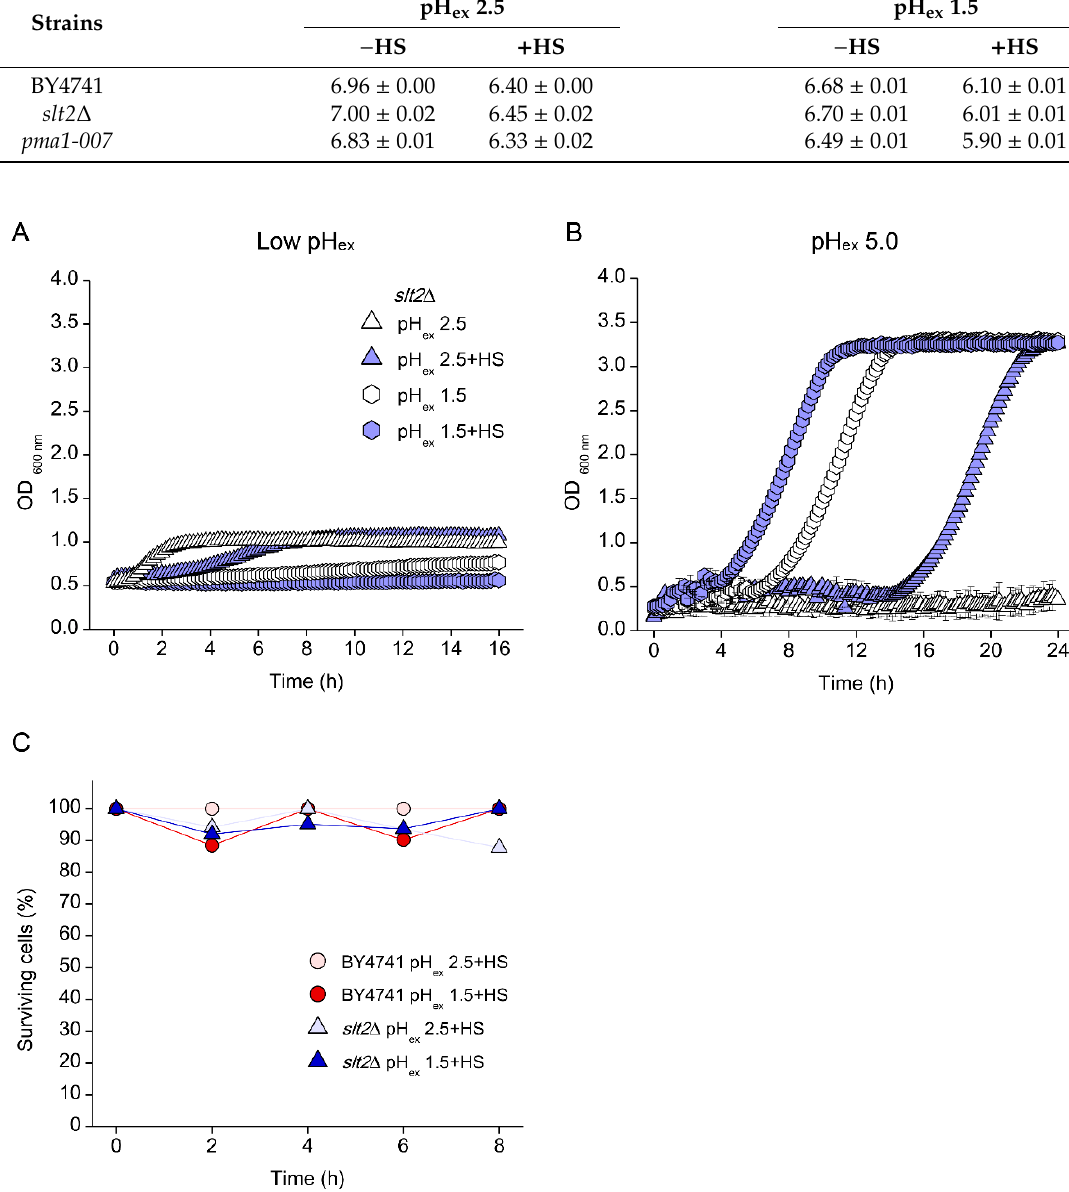
Figure 7. E ff ect of sorbic acid on the growth profile of S. cerevisiae slt2 ∆ mutant cultivated in low external pH (pH ex ) medium. ( A ) Cells of were cultivated in YNB adjusted to pH 2.5 (blue triangles) or pH 1.5 (blue hexagon) with sulphuric acid in the absence (open symbols) or presence (closed symbols) of sorbic acid at 1.2 mM. ( B ) At the end of cultivations, their cells were collected and transferred to YNB pH 5.0. ( C ) Cultures of BY4741 (circles) and slt2 ∆ (triangles) strains in YNB containing sorbic acid and adjusted with sulphuric acid to pH 2.5 (light red and blue) or 1.5 (dark red and blue) were evaluated for the percentage of viable